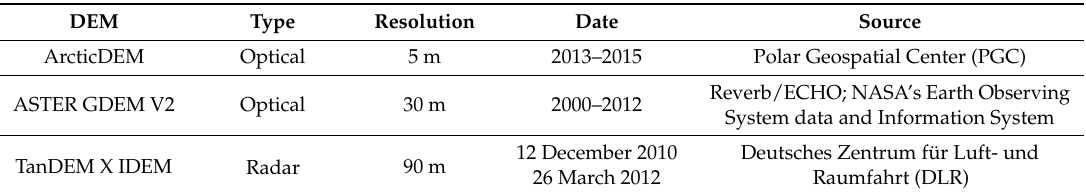
Table 3. An overview of the DEMs used in the